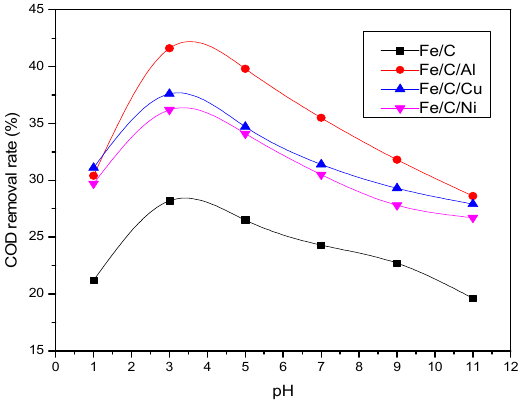
Figure 2. Influence of different metal catalysts on COD removal rate.